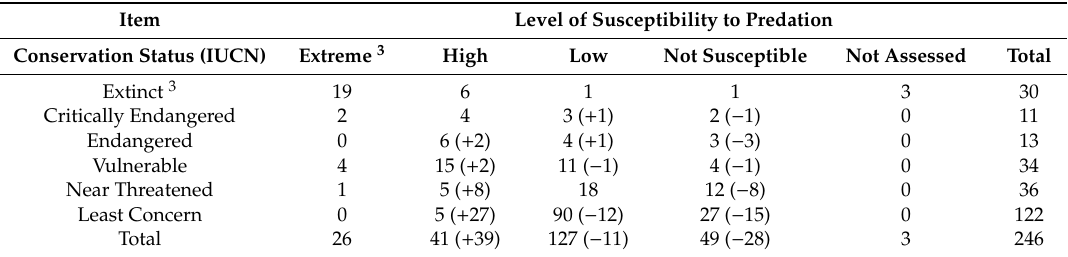
Table 1. Numbers of native, non-volant Australian terrestrial mammal species (n = 246) categorised as susceptible to predation by the domestic cat 1 and savannah cat 2 (shown as numbers in parentheses as changes from values for the domestic cat), cross-tabulated with their IUCN conservation